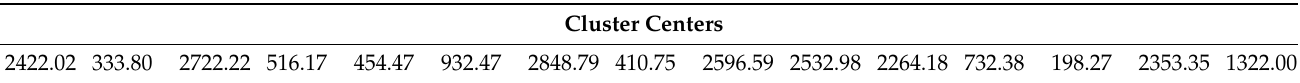
Table 3. Cluster centers found by the k-Means clustering and used to center the 15 Gaussian membership functions in this